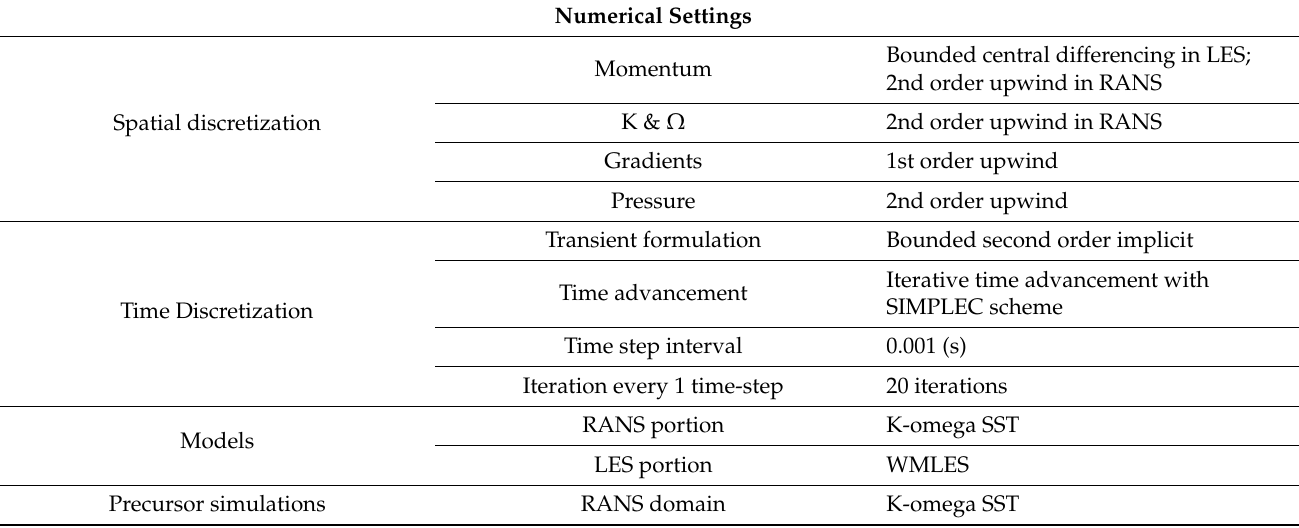
Table 3. A summary of the current numerical